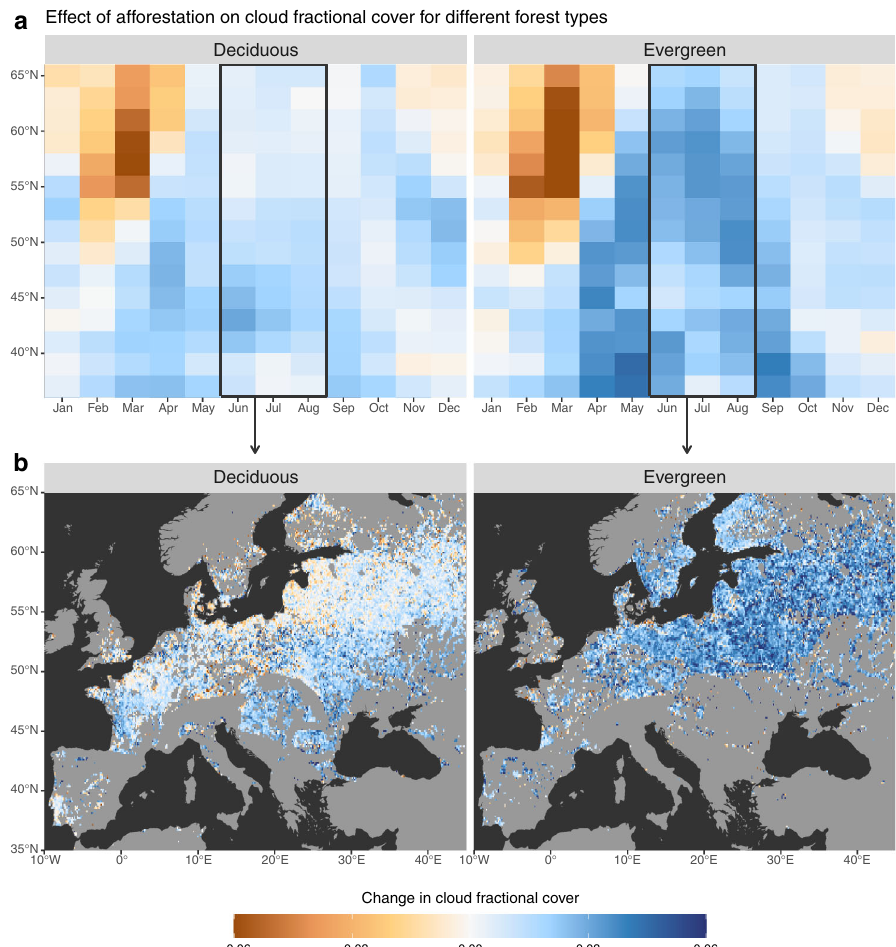
Fig. 5 Change in cloud fractional cover following afforestation of two different forest types: deciduous forests or evergreen forests. a The latitudinal monthly averages over the entire areas. b The spatial distribution of the averaged summer